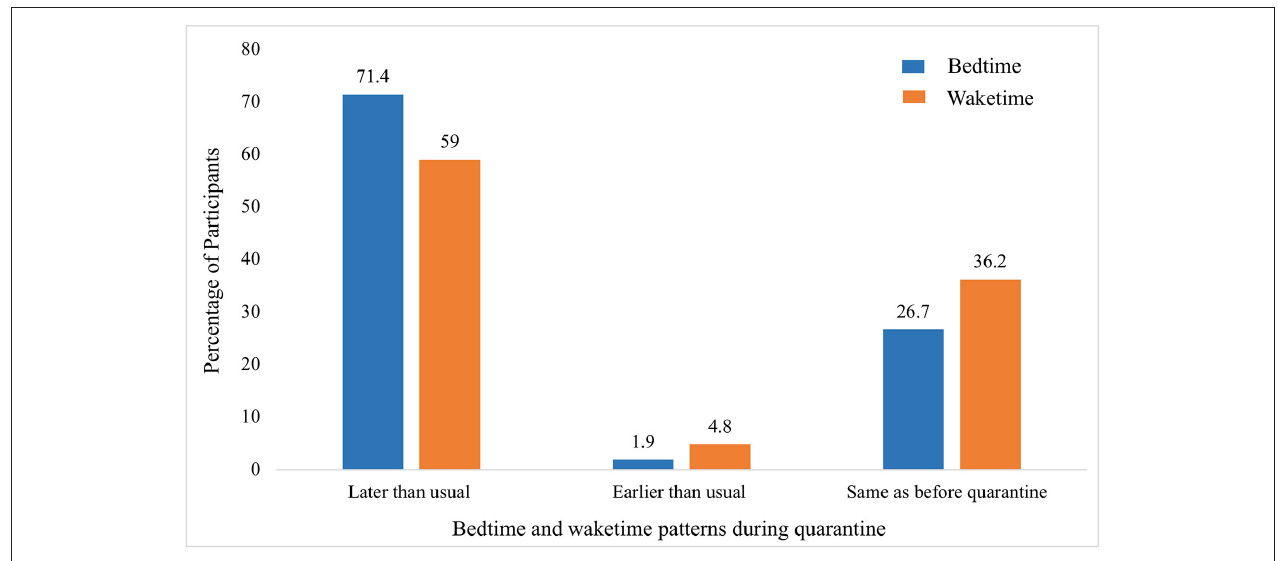
FIGURE 3 | Changes in sleep patterns during